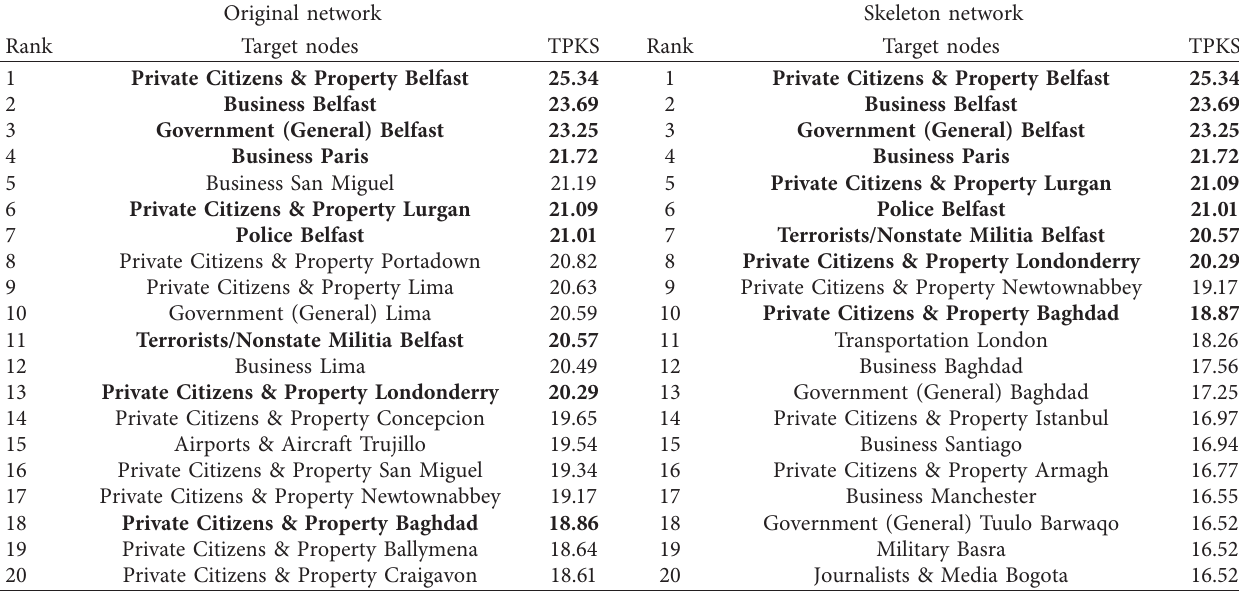
Figure 3: The correlation matrix of the terrorist’s features comparing between (a) the original network and (b) the skeleton network. Table 2: Top 20 targets of the skeleton network comparing with the original global terrorism